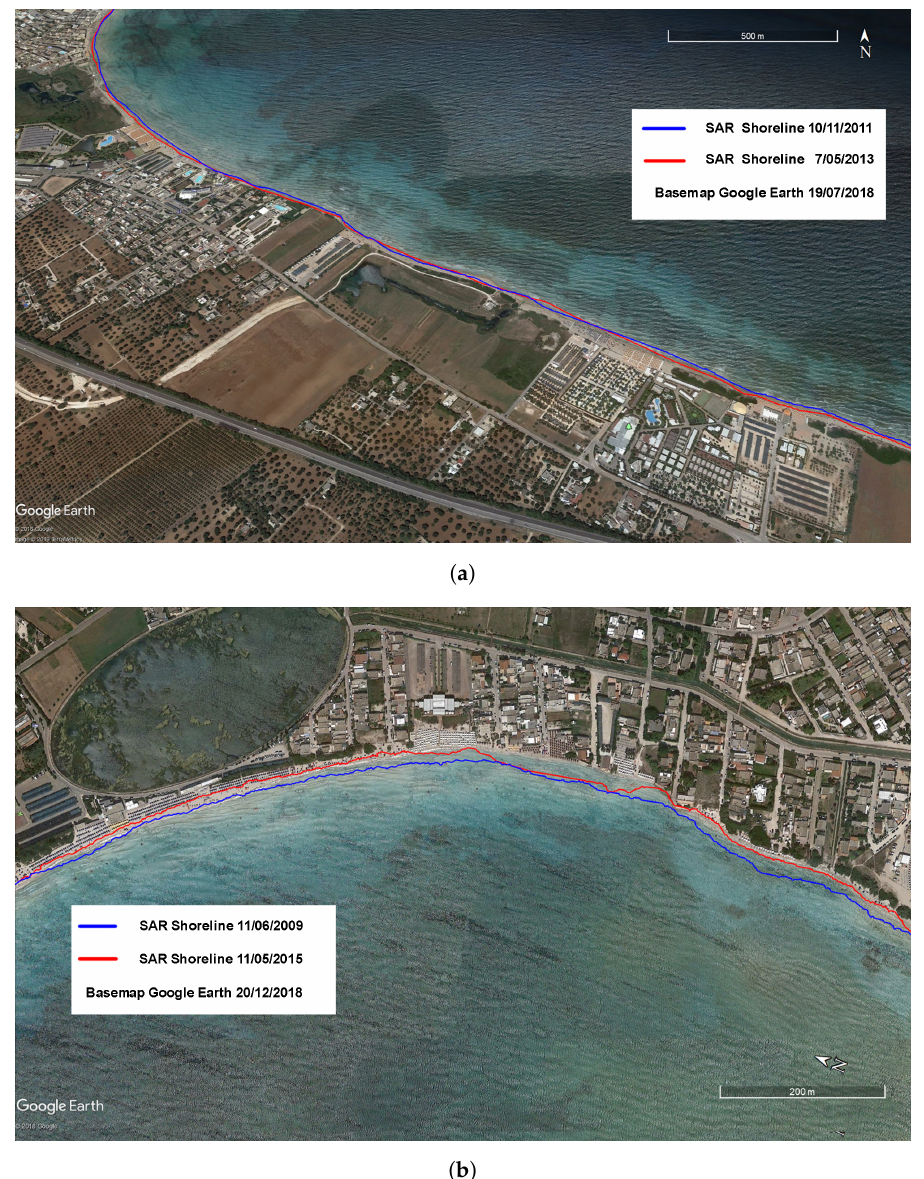
Figure 9. Shoreline changes detected from SAR images (blue line for the oldest SAR shoreline, red line for the most recent): ( a ) Test site I (Porto Cesareo); ( b ) Test site II (Torre